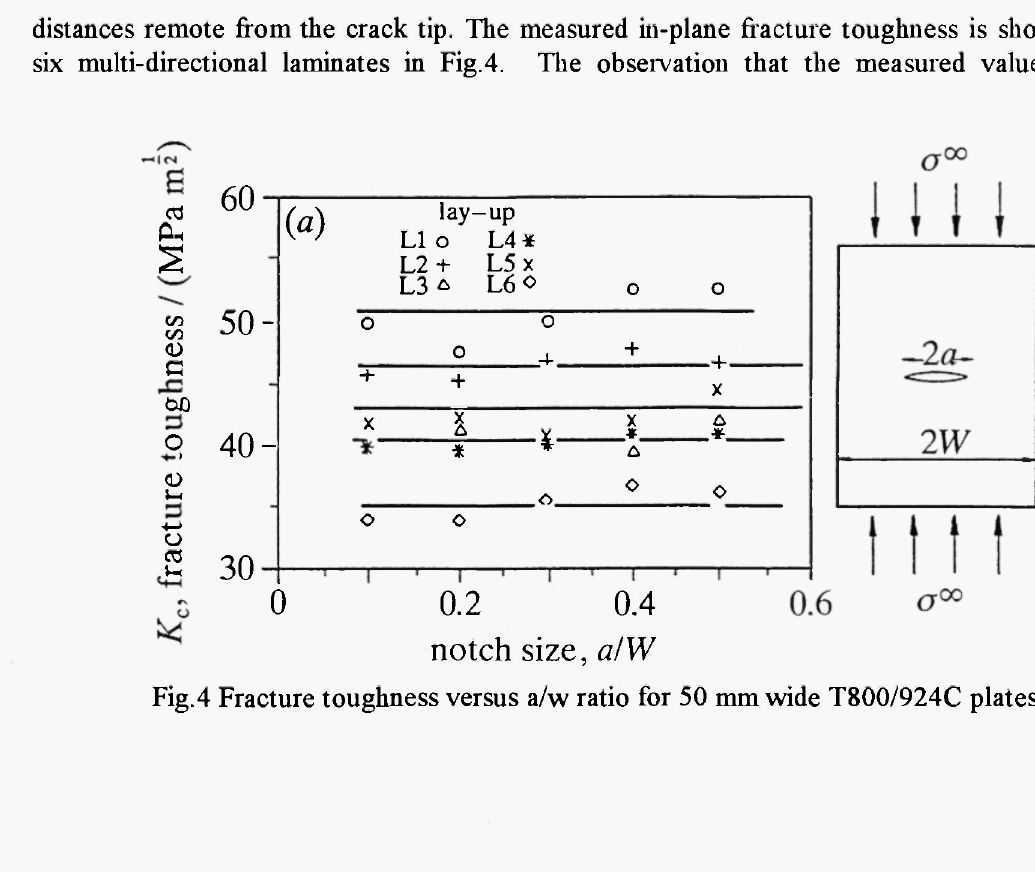
Fig.4 Fracture toughness versus a/w ratio for 50 mm wide T800/924C